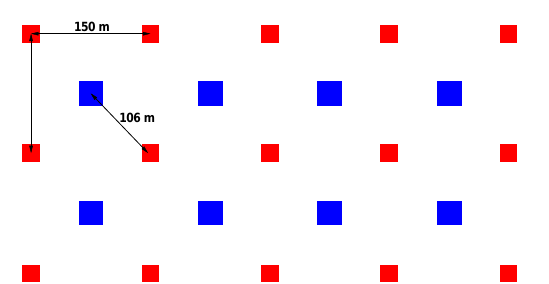
Figure 1: Array layout planned for the Tunka- HiSCORE engineering array. In the standard layout (simulated configuration) four 8 inch PMTs are used per station (red squares). Additional stations with larger PMTs (10 or 11 inch) are envisaged for the engineering array (blue squares).